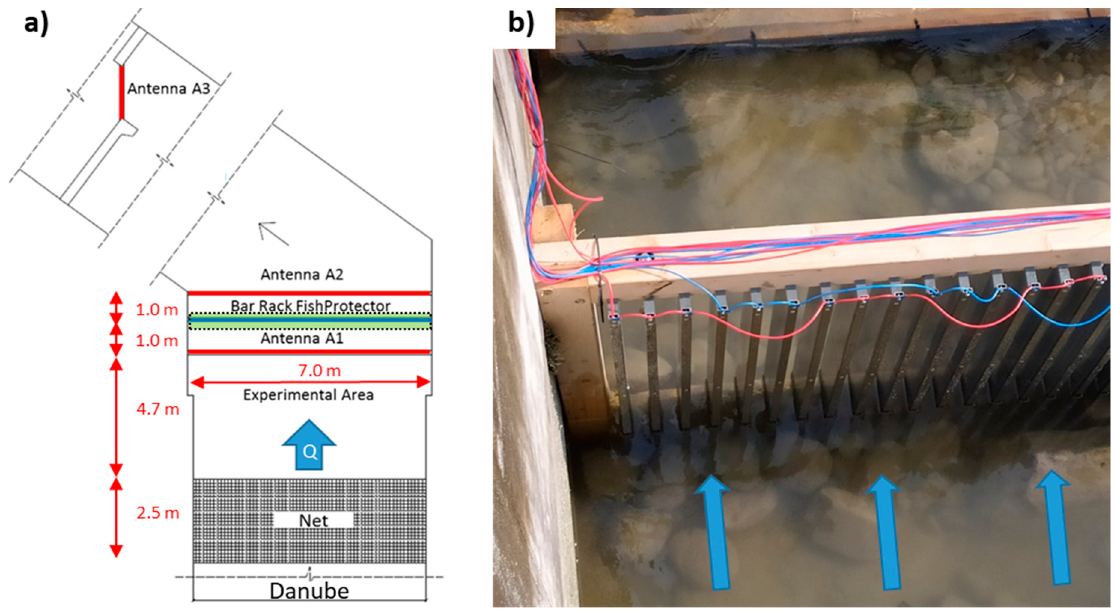
Figure 1. Experimental setup ( a ) in plan view; Bar Rack FishProtector in blue, approximate effective extensions of the electric field with U = 80 V in light green with dotted black line, Pit-Antennae A1-A3 in red and diversion net upstream of the experimental area and ( b ) close-up of the Bar Rack FishProtector with electrodes, cable connections and approach flow indicated with arrows.